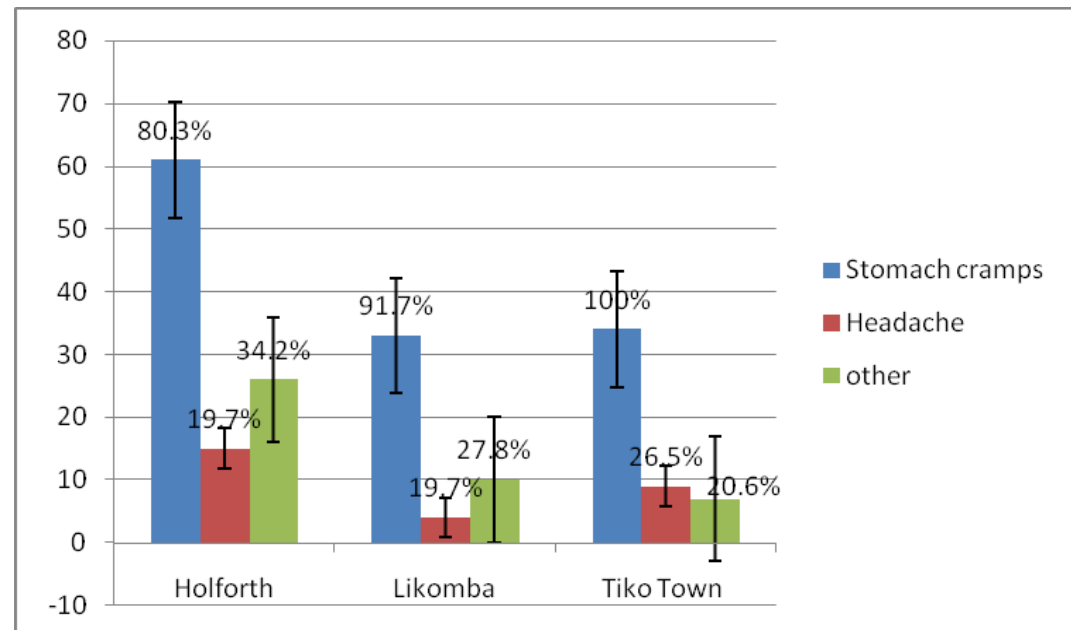
Figure 2. Diarrhea symptoms experienced by participants per health area in Tiko city